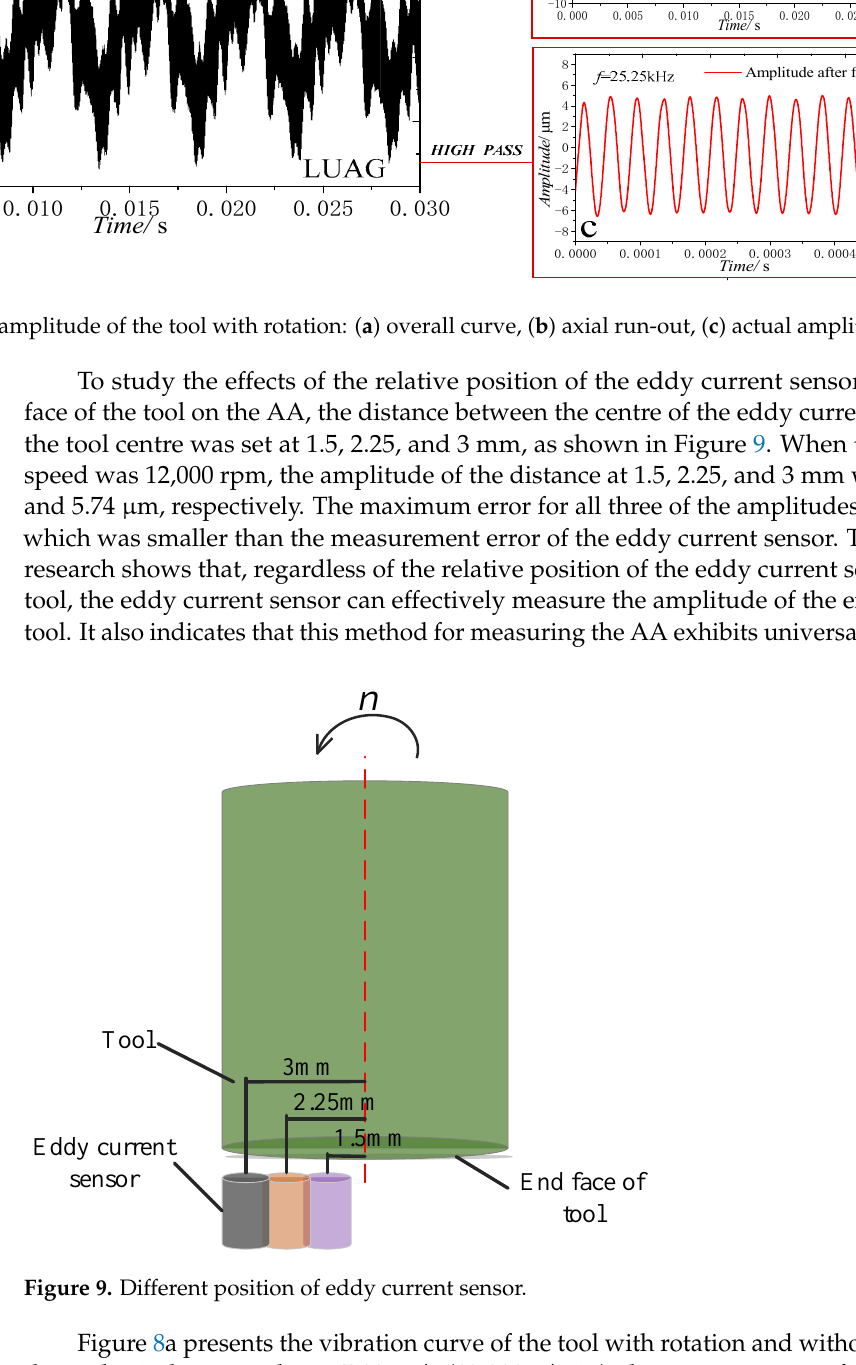
Figure 8. Ultrasonic amplitude of the tool with rotation: ( a ) overall curve, ( b ) axial run-out, ( c ) actual amplitude.